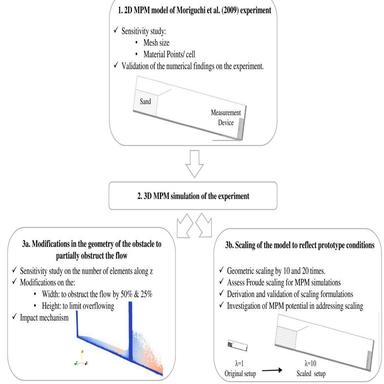
Outline of the methodology.